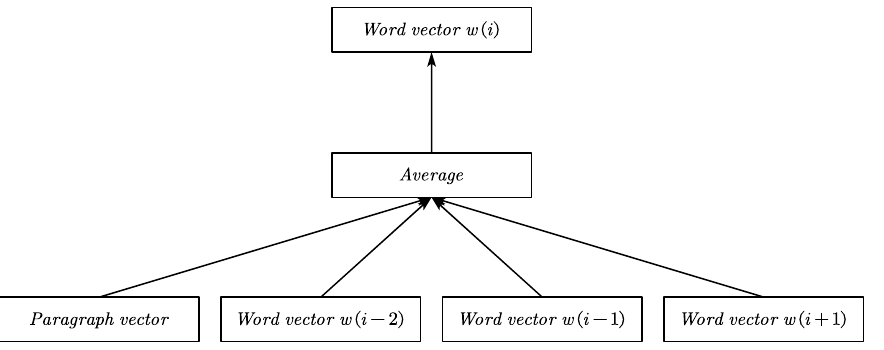
Figure 2. PV ‐ DM model. Figure 2. PV-DM model.